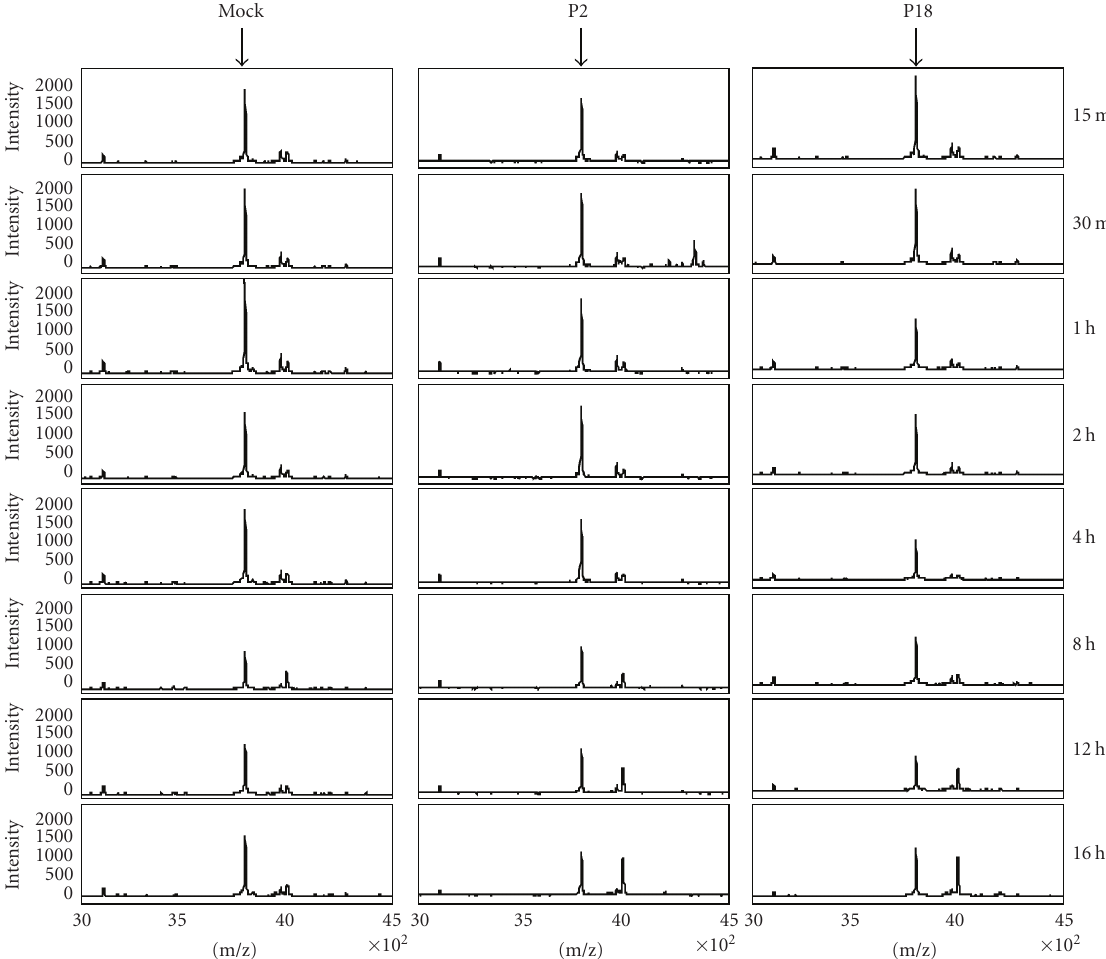
Figure 2: Di ff erential intensity of prothymosin- α peak. SELDI mass spectrometry analysis of triplicate cytoplasmic extracts from mock-, P2-, or P18 PICV-infected P388D1 cells over a time course of infection shows di ff erential intensity of a protein peak (indicated by the arrows) at m/z approximately 3790 ( Q = 0 . 0164). This peak was identified as prothymosin- α by tandem mass spectrometry. The figure shows one representative set of spectra from three independent